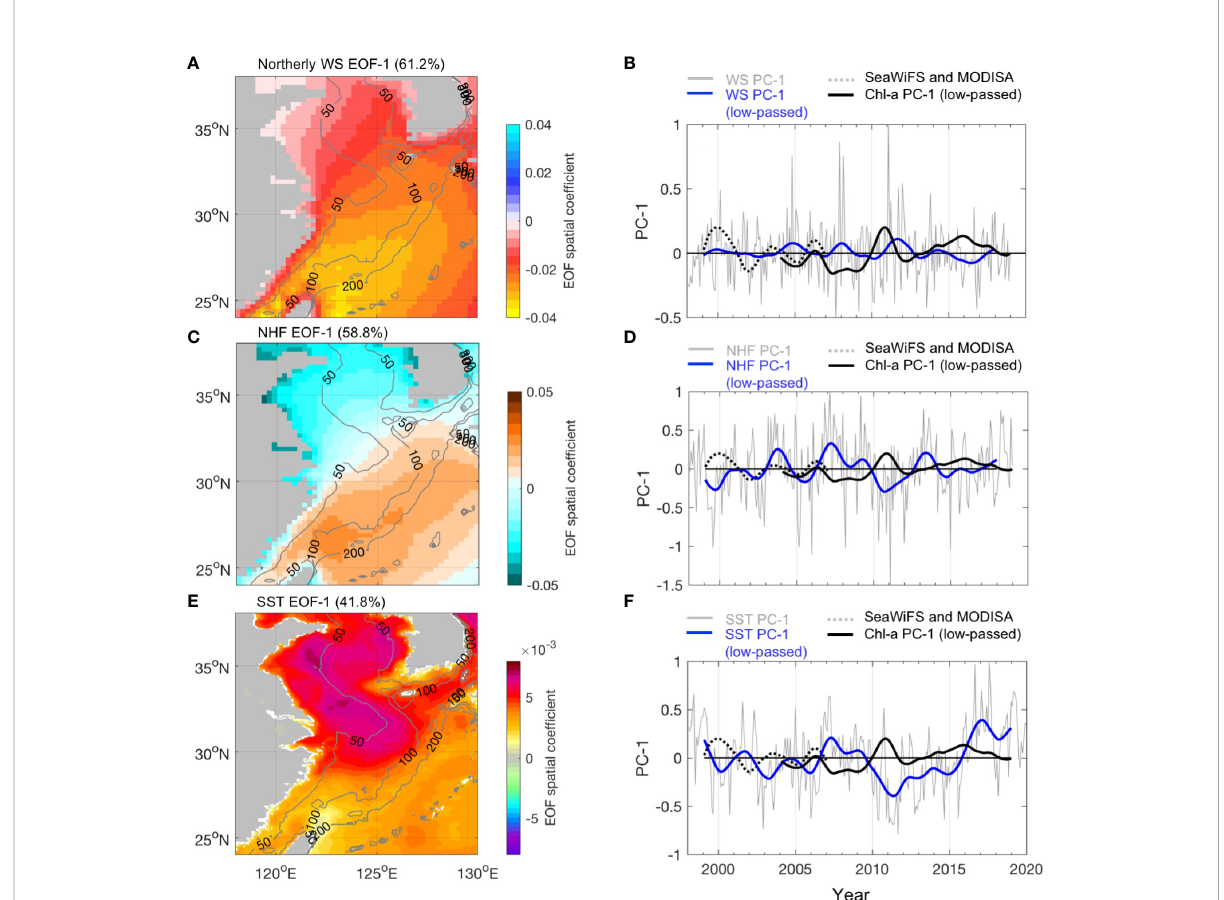
FIGURE 6 The fi rst EOF mode for northerly wind, SST, and NHF. (Left) The EOF spatial coef fi cient. The gray contour lines in each map denote the 50-, 100-, and 200-m isobaths. (Right) (Left A, C , E ) the EOF spatial coef fi cient. The black dashed and thick lines in (B – F) indicate the 12-month low- pass- fi ltered PC-1 for SeaWiFS and MODISA Chl -a ,